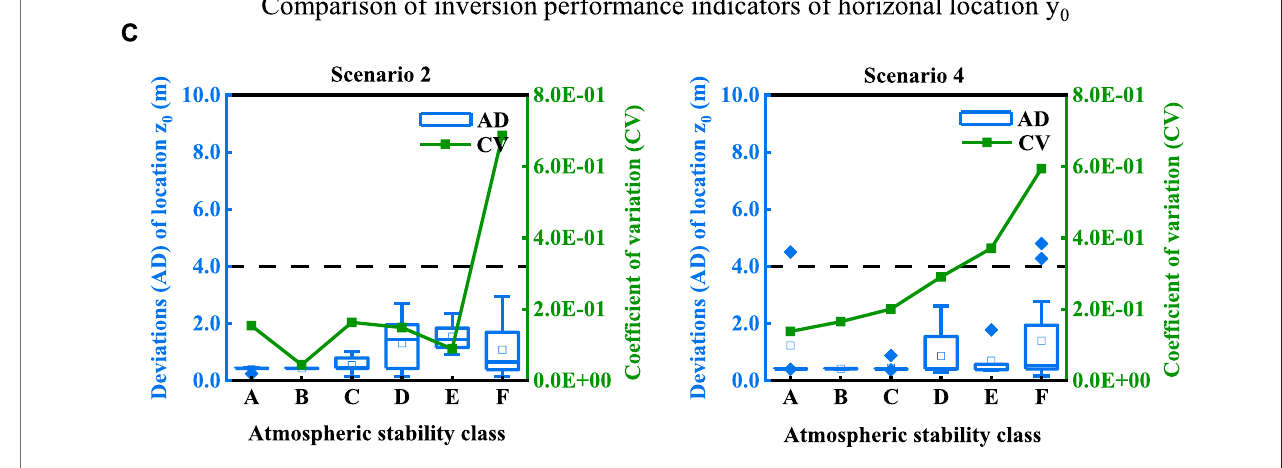
Frontiers in Environmental Science |